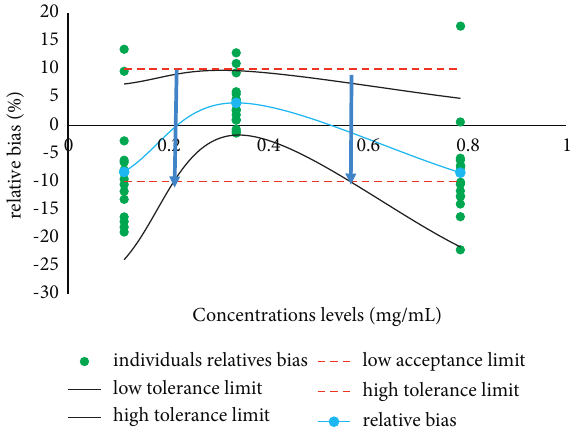
Figure 4: Accuracy profile obtained with the polynomial function applied to peak areas.